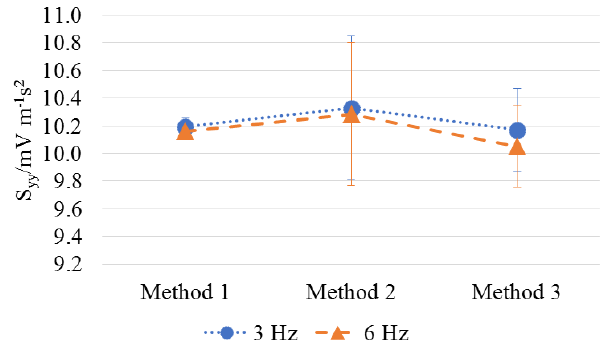
Figure 13. MEMS accelerometer: sensitivity matrix obtained by means of Method 1 (3-D diagram).